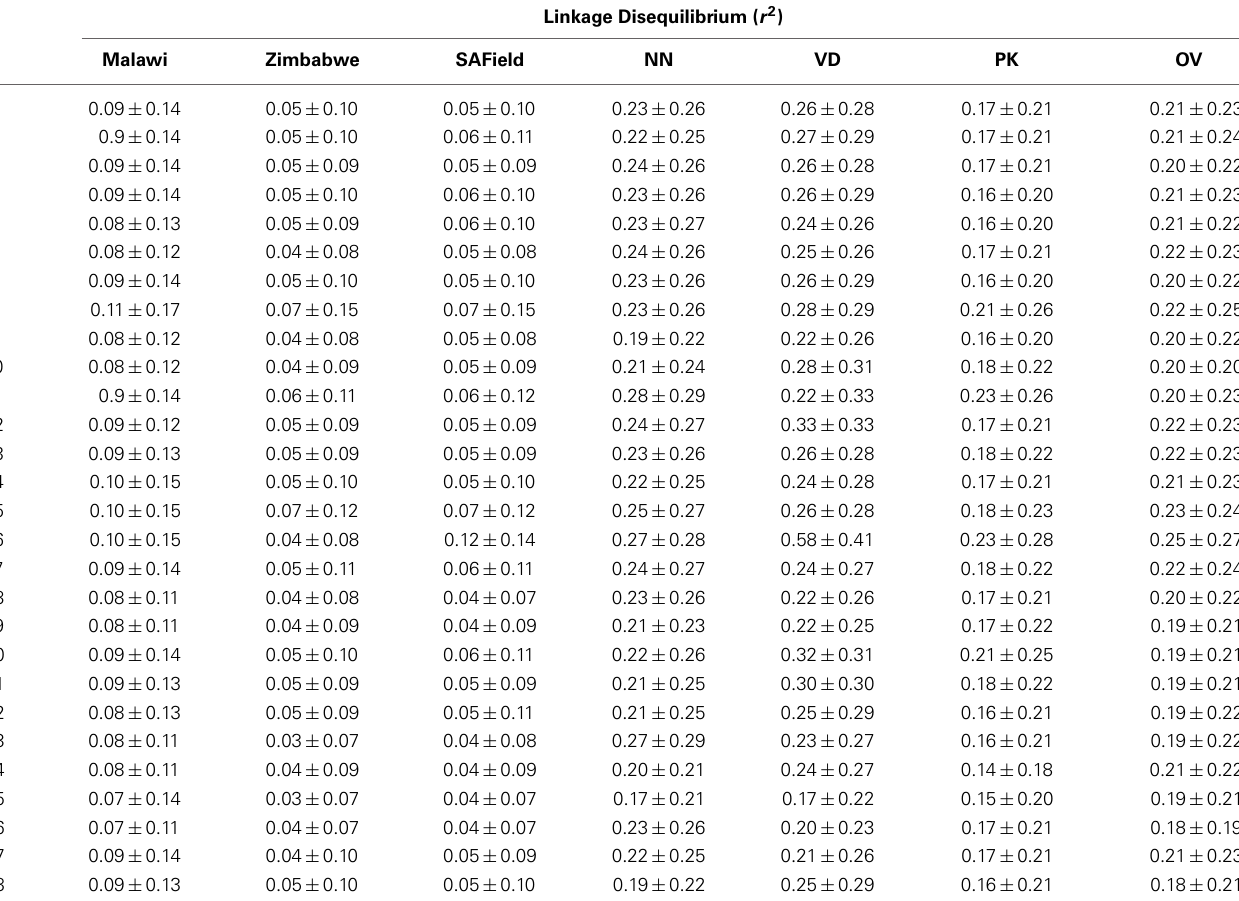
Table 2 | Linkage disequilibrium of Malawi, Zimbabwe, South African Field (SAField) village chickens and the Naked Neck (NN), Venda (VD), Potchefstroom Koekoek (PK) and Ovambo (OV) conservation flocks. Linkage Disequilibrium ( r 2 ) Malawi Zimbabwe SAField